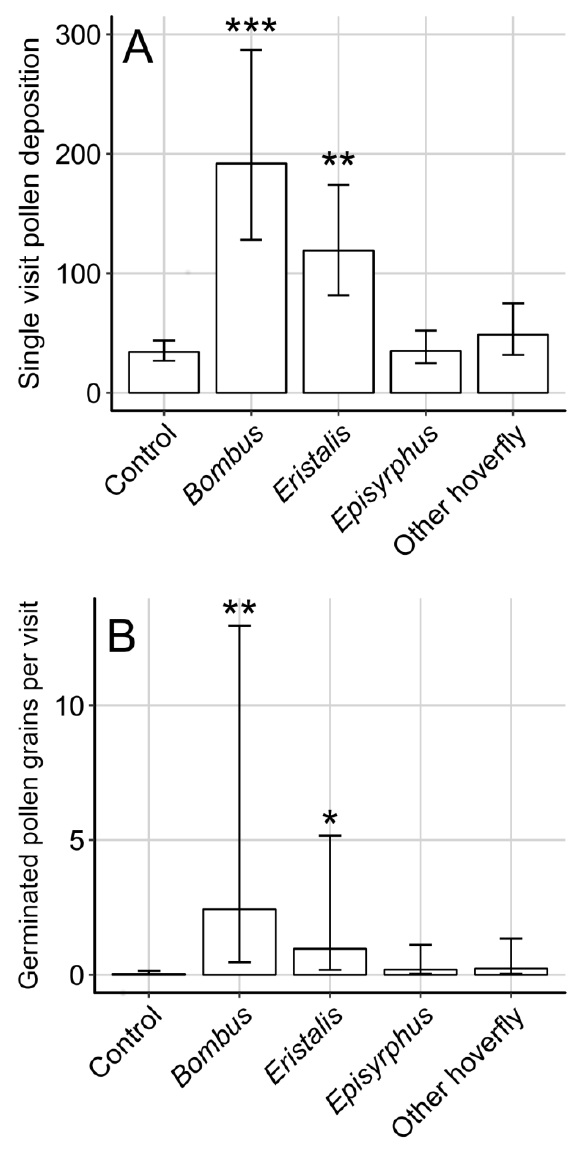
F IGURE 3. Pollinator performance of insect visitors on Brassica rapa (turnip) showing that Bombus and Eristalis were the most effective individual pollinators estimated by (A) single visit pollen deposition (SVD) and (B) pollen germination. Asterisks show significance in comparison to the controls: ‘***’ = P < 0.001; ‘**’ = P < 0.01; ‘*’ = P < 0.05. Estimates (mean ± 1 SE) are produced from final model (see Tab. 1 for statistics and